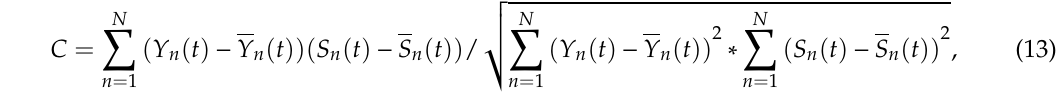
Figure 4. The original signal generated from the source signals using a mixing matrix. ( a ) The curve of the first mixed signal, ( b ) the curve of the second mixed signal, and ( c ) the curve of the third mixed